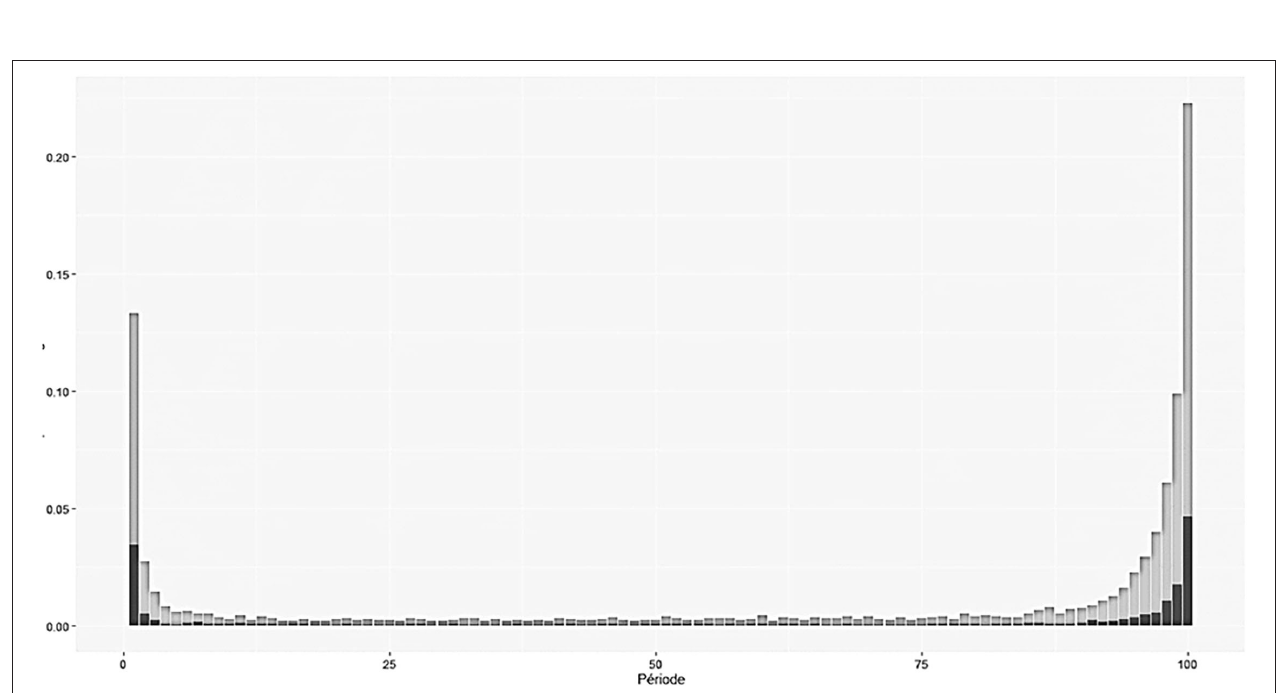
FIGURE 2 | Distribution during the nursing task (from room entry to room exit) of alcoholic hand rub among 16,416 nursing tasks, 12,759 classified standard task procedures STP (in gray) and 2,853 aseptic tasks procedures ATP (in black). Hand hygiene is more frequently performed at the end of the task when standard task procedure nursing is performed (Kolmokorov-Sirnov 0.84 p < 2.2 E-16). In aseptic task procedure nursing the AHR is performed in a similar way at entry that at exit.